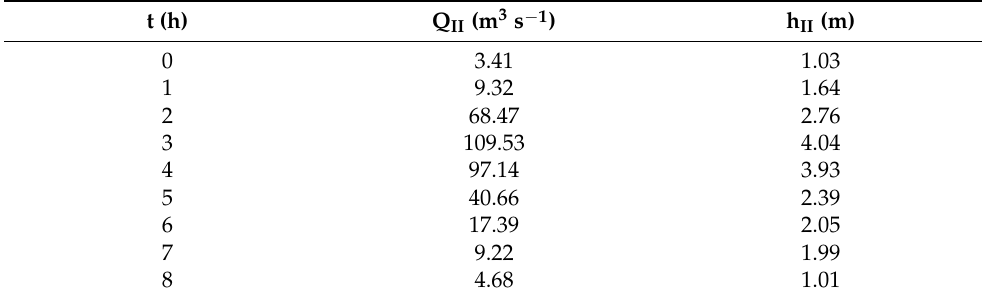
Table 5. Discharge Q II, (m 3 s − 1 ) and water level h II, (m) values for the green–blue flood control sce- nario II at “Bridge B” cross-section and t (h) is the time from the beginning of the output hydrograph.